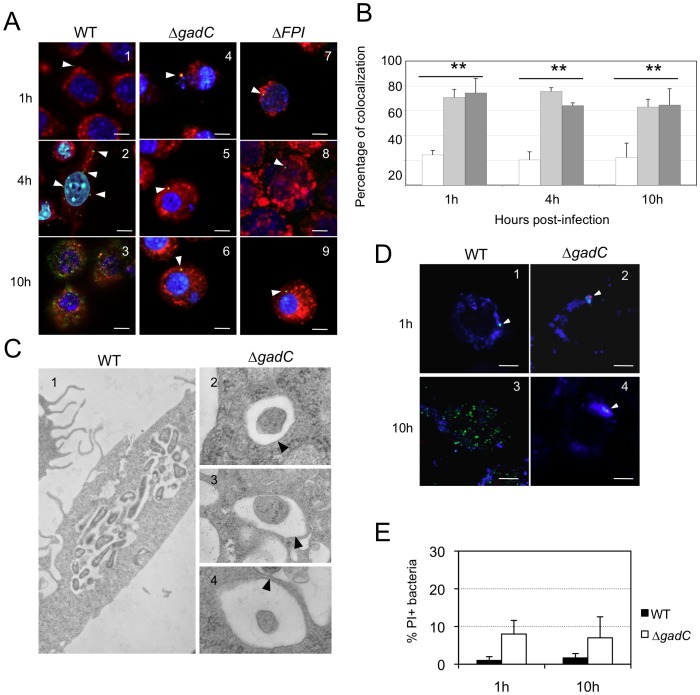
Subcellular localization of the ΔgadC mutant.(A) Co-localization of wild-type F. novicida (1, 2, 3), ΔgadC (4, 5, 6) or ΔFPI mutant strain (7, 8, 9) with LAMP-1 was monitored by confocal microscopy, in J774.1 macrophage cells. Co-localization was monitored at 1 h (1, 4, 7), 4 h (2, 5, 8) and 10 h (3, 6, 9). Anti-Francisella antibody was used at a final dilution of 1∶500 and is shown in green. Anti-LAMP-1 antibody was used at a final dilution of 1∶100 and is shown in red. White arrowheads point to individual bacteria. Cell nuclei were labeled with DAPI (in blue). The images are representative from triplicate coverslips in three independent experiments. Scale bars at the bottom right of each panel correspond to 10 µM. (B) Quantification of co-localization between bacteria and LAMP-1 was obtained with Image J software. The graph results from the analysis of 4 different fields for each time of infection, in three independent experiments. **, p<0.01 (as determined by the Student's t-test). White bars, F. novicida U112 (WT); light grey bars, ΔgadC; dark grey bars, ΔFPI. (C) Transmission electron micrographs of thin sections of J774.1 macrophages, infected by wild-type F. novicida and ΔgadC mutant strains. Infections were monitored over a 10 h-period. At 10 h, active cytosolic multiplication of wild-type F. novicida was observed in most of the infected cells (1) whereas the ΔgadC mutant remains trapped into spacious phagosomes (2, 3, 4). Black arrowheads point to intact phagosomal membrane. (D) To evaluate the viability of intracellular Francisella, labeling with the cell-impermeant nucleic acid dye propidium iodide (PI) was performed. Confocal images of J774.1 cells, infected with wild-type F. novicida (1, 3) or ΔgadC mutant (2, 4) strain; after 1 h (1, 2) and 10 h of infection (3, 4). Intact bacteria are labeled in green. Bacteria with compromised membranes are labeled with PI and appear in red (or a red spot). Phagosomes are labeled in blue. Scale bars at the bottom right of each panel correspond to 10 µM. (E) Quantification of the percentage of dead bacteria. At least 100 bacteria per experiment were scored for PI labeling at 1 h and 10 h post infection. Data are means ± standard deviation from three independent assays.